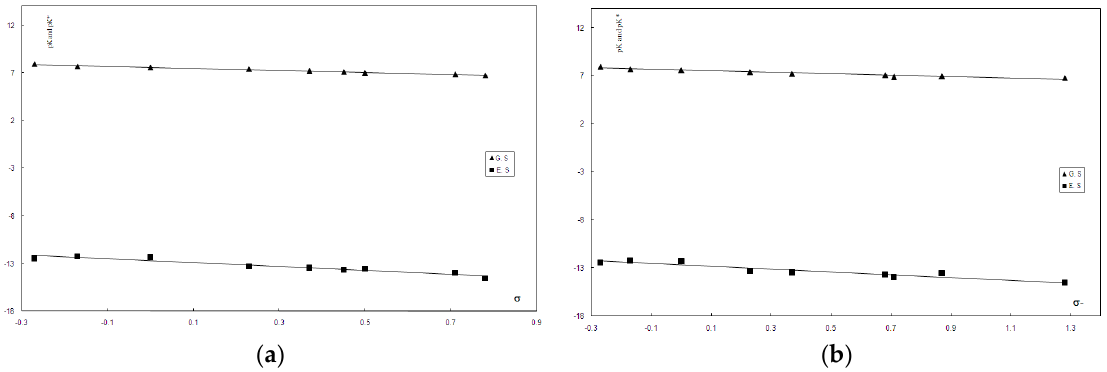
Figure 2. ( a ) Correlation of pK and pK* of 4-(5-arylazo-2-hydroxystyryl)-1-methylpyridinium iodide 6a – i with Hammett substituent constants σ ; ( b ) Correlation of pK and pK* of 4-(5-arylazo-2-hydroxystyryl)-1-methylpyridinium iodide 6a – i with enhanced Hammett substituent constants σ − .